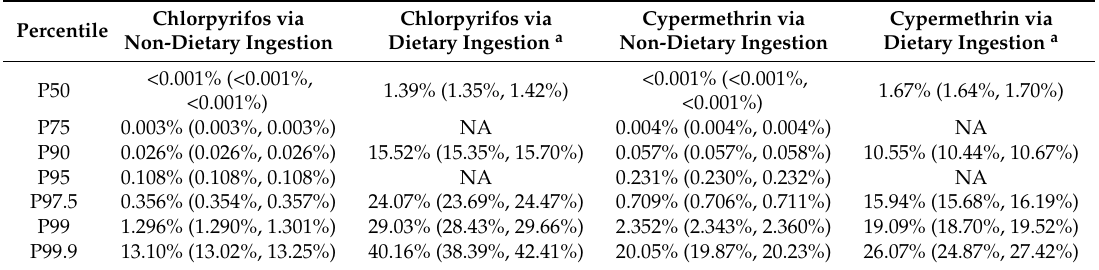
Table 3. Comparison of non-dietary and dietary ingestion exposures in terms of percentage of ADI.